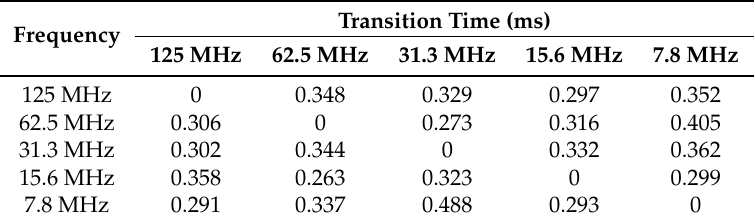
Table 7. Transition time in the